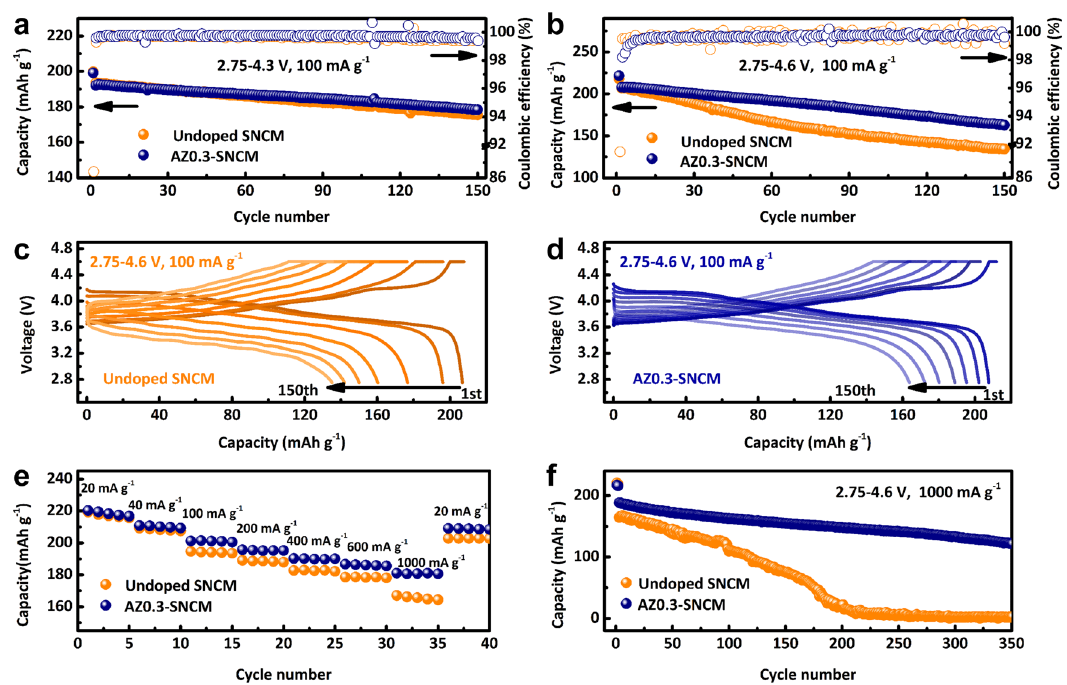
Fig. 2 Electrochemical characterizations of coin-type half-cell at 25 °C. (Li metal anode and 1 M LiPF 6 in EC/DEC (1:1 in volume) are used as the counter electrode and electrolyte, respectively.) Cycling stability for undoped SNCM and AZ0.3-SNCM within the voltage range of 2.75 – 4.3 V ( a ) and 2.75 – 4.6 V ( b ) at 0.5 C (100 mA g − 1 ). Charge/discharge curves for undoped SNCM ( c ) and AZ0.3-SNCM ( d ) at 0.5 C (100 mA g − 1 ) within the voltage range of 2.75 – 4.6 V. Rate performance ( e ) and cycling stability ( f ) for SNCM and AZ0.3-SNCM at 5 C (1000 mA g − 1 ) within the voltage range of 2.75 – 4.6 V,